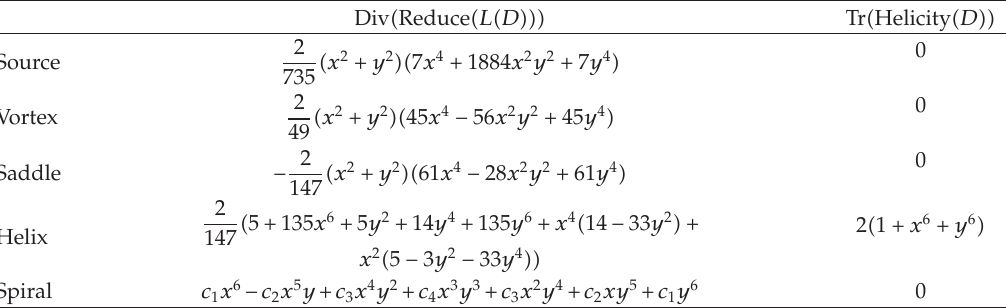
Table 6: Detecting saddles and helices in fourth-order tensor